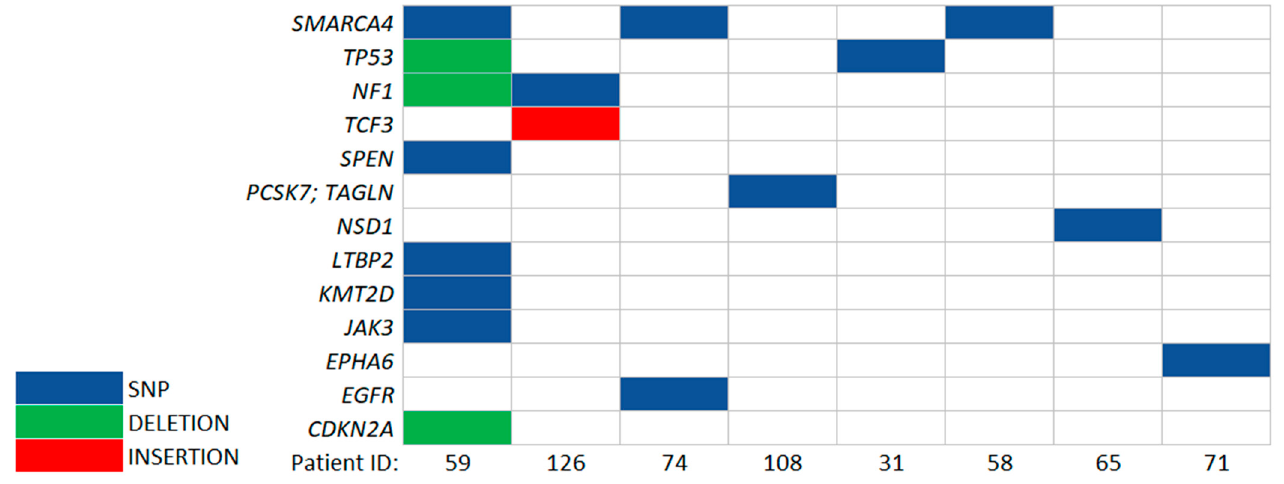
Figure 6. Somatic variants detected in ccfDNA and confirmed as somatic variants in tumor samples. The presence of specific alterations such as SNP, deletion, or insertion in a given patient sample is indicated. Table 2. Cosmic registered variants found in ccfDNA but not in gDNA.